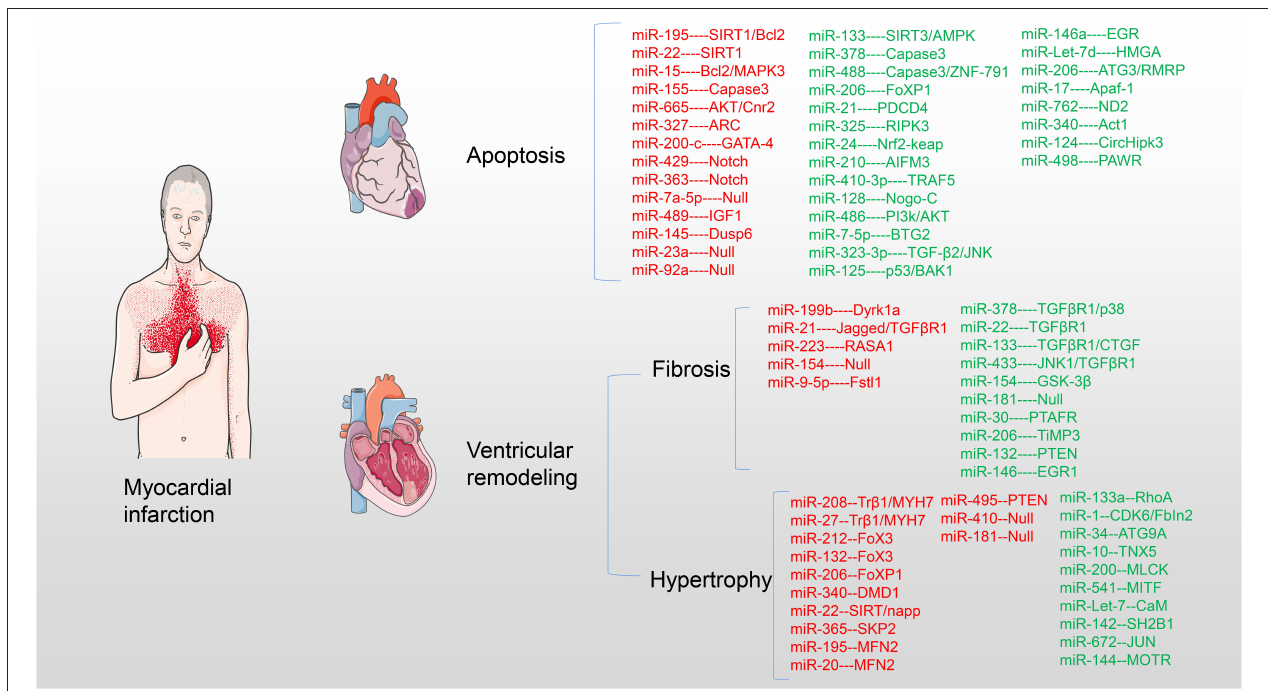
FIGURE 2 | miRNAs target myocardium in pathological process after MI. miRNAs are involved in myocardial cell apoptosis, myocardial fibrosis, and myocardial hypertrophy acting on myocardial targets after MI. Upregulation of red miRNAs promoted the development of pathology, while upregulation of green miRNAs inhibited or even reversed the pathological